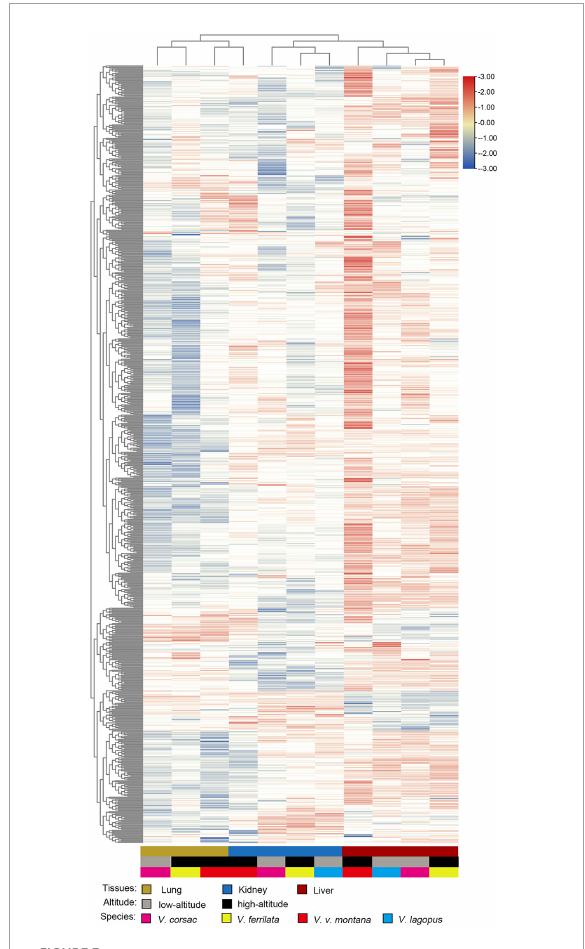
FIGURE3 Heat map of genes enriched for expression in each tissue of Vulpes (i.e., Vulpes lagopus , Vulpes vulpes montana , Vulpes ferrilata , and Vulpes corsac ). The heat map was generated using hierarchical clustering and complete linkage of the one-to-one orthologous genes. Distances, representing the relative similarity among genes and tissues, were calculated using Pearson’s correlation coefficients. Color represents FPKM value of gene expression after scaling and